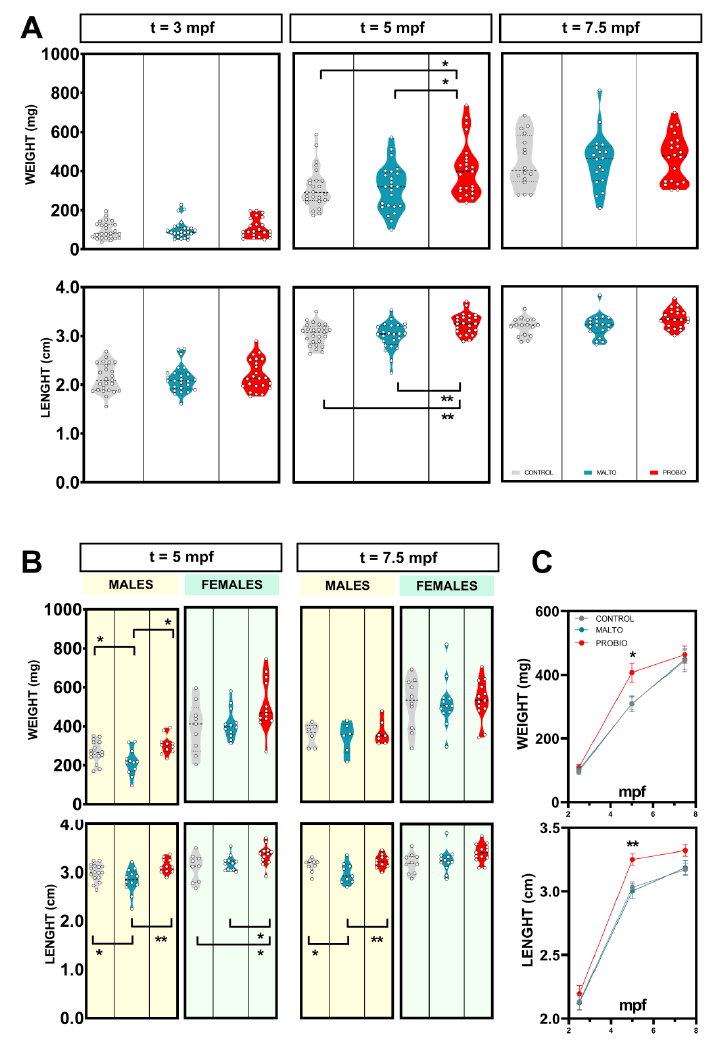
Figure 2. Feeding with probiotics promotes growth in zebrafish model. ( A ) Violin plots showing growth parameters (weight and length) before the beginning of the experimental diet (3 mpf), after 2 months (5 mpf), and 4.5 months (7.5 mpf). ( B ) Growth parameters comparison divided by sex at 5 and 7.5 mpf. Black dot lines in the violin plots represent median (wider) and quartiles (thinner). ( C ) Growth parameters evolution (mean values ± s.e.m.) during the experiment for the three experimental groups. “CONTROL”, “MALTO”, and “PROBIO” refer to the experimental groups: control diet-fed, maltodextrin-fed, and probiotics-fed, respectively. Asterisks show statistically significant differences: * ( p < 0.0500), ** ( p < 0.0100).